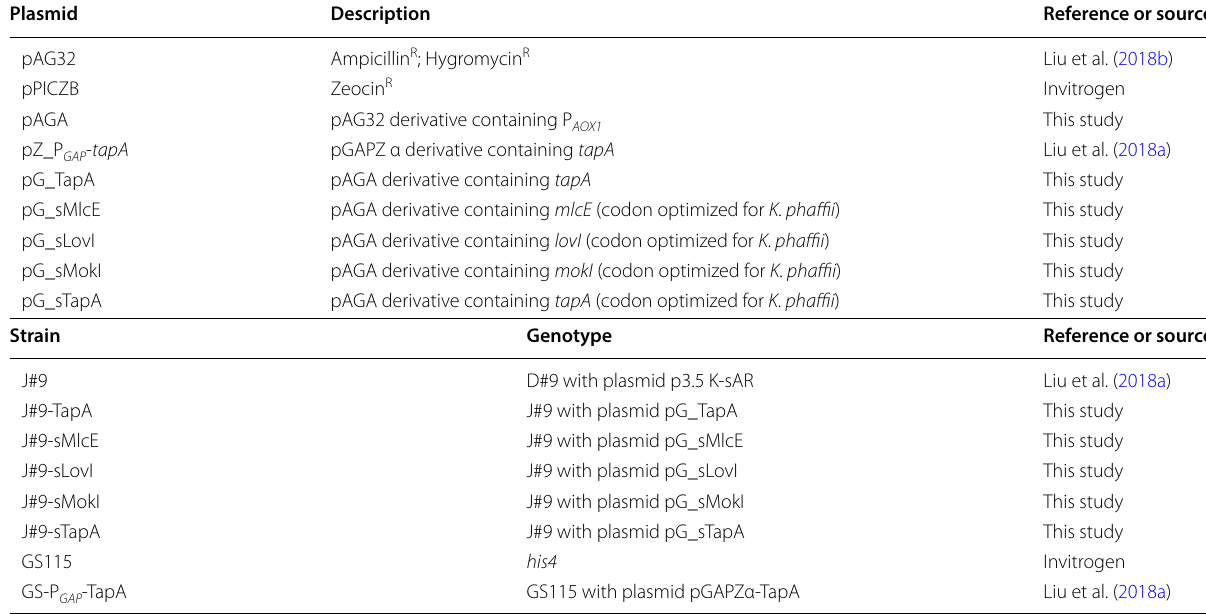
Table 1 Plasmids and strains used in this study Plasmid